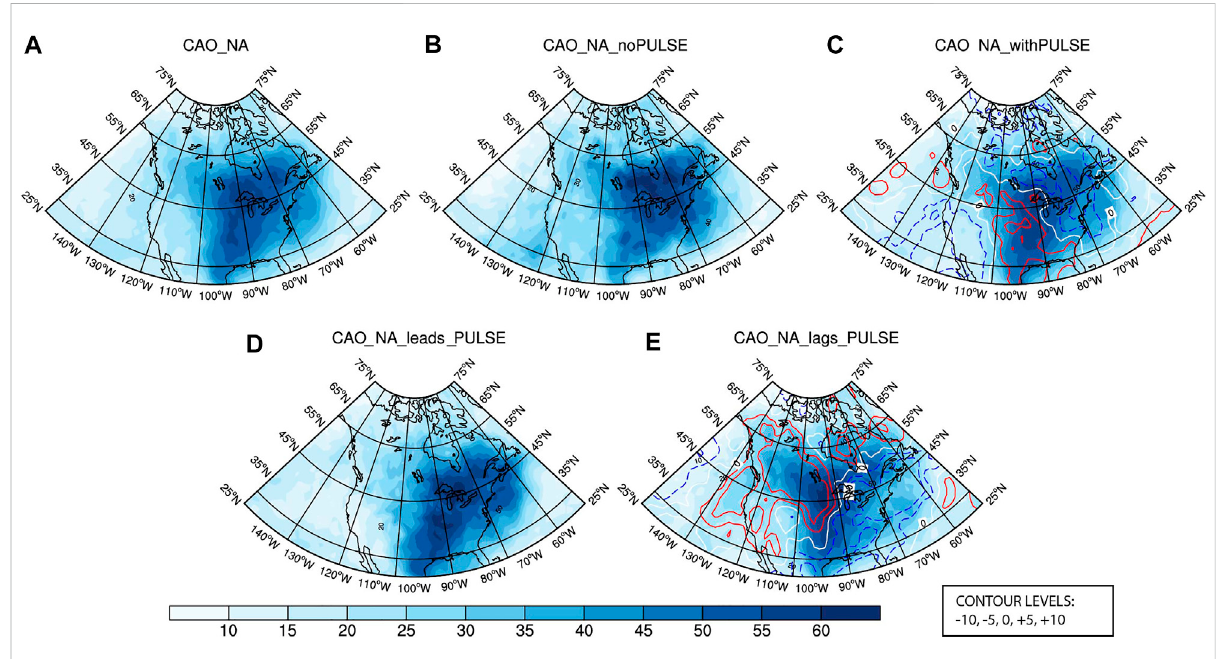
FIGURE 2 Similar to Figure 1 but for the occurrence probability of SAT anomalies < − 1 LSD during CAO_NA events in the North American